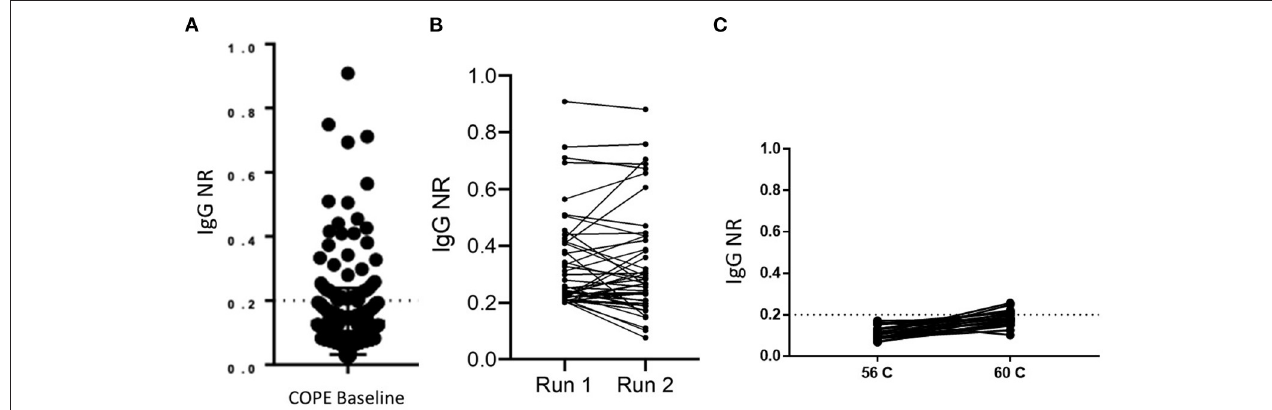
FIGURE 2 | Implementation of RBD IgG ELISA for surveillance. (A) The distribution of RBD ELISA results are shown for a cross-sectional sample of 353 healthcare personnel. The dashed line at NR = 0.2 indicates the assay cut off. (B) Run-to-run concordance is shown for samples that initially tested positive by RBD ELISA ( n = 45). (C) Paired results in the RBD ELISA are shown for negative control samples which had one aliquot heat inactivated at the indicated temperature ( n =